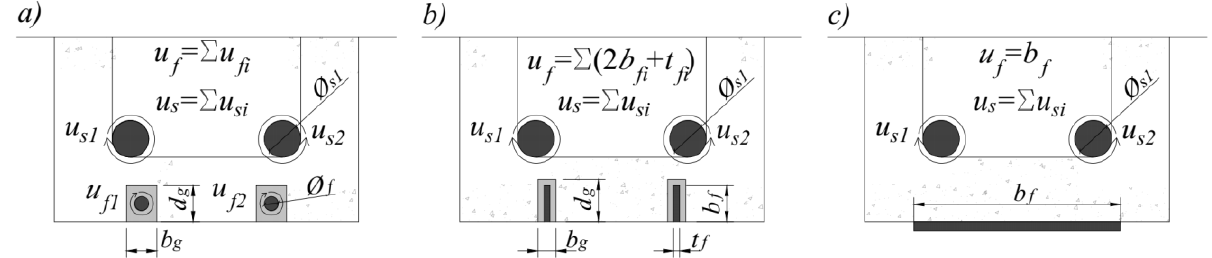
Figure 2. Main types of FRP reinforcements used for strengthening ( a ) NSM rods, ( b ) NSM strips, and ( c ) EBR sheets/laminates.